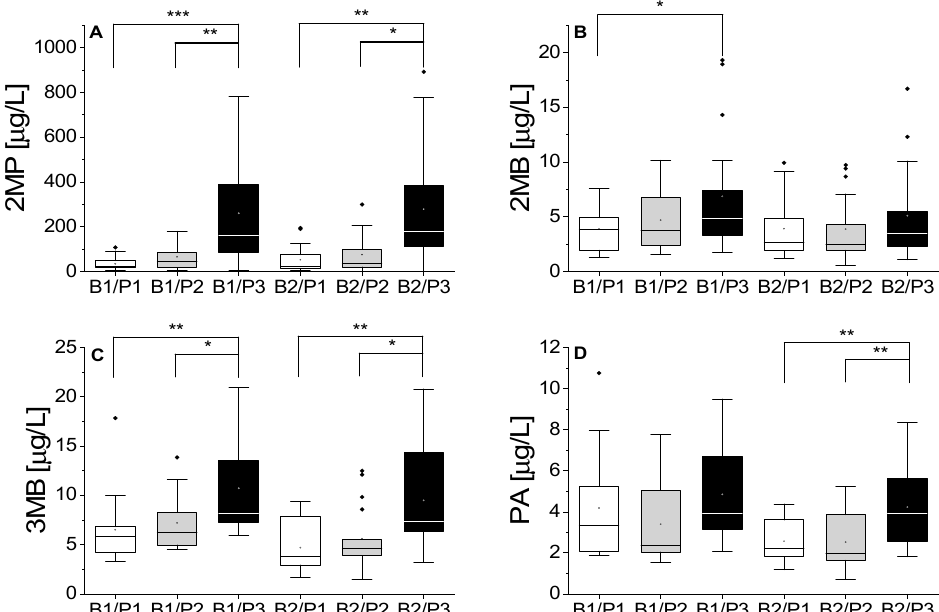
Figure 2. Boxplots of all aging points of chosen aldehydes (( A ) 2MP; ( B ) 2MB; ( C ) 3MB; ( D ) PA) by malt modification level (B1: barley variety 1; B2: barley variety 2; P1: low proteolytic malt modification; P2: medium proteolytic malt modification; P3: high proteolytic malt modification). Linked boxplots showed a significant difference (*: p < 0.05; **: p < 0.01; ***: p < 0.001).